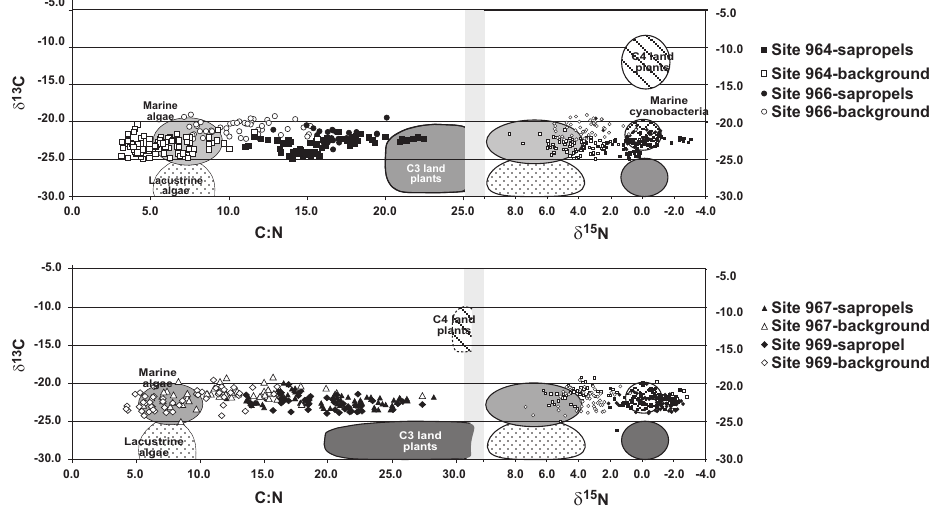
15 N, δ 13 C and C:N ratios.